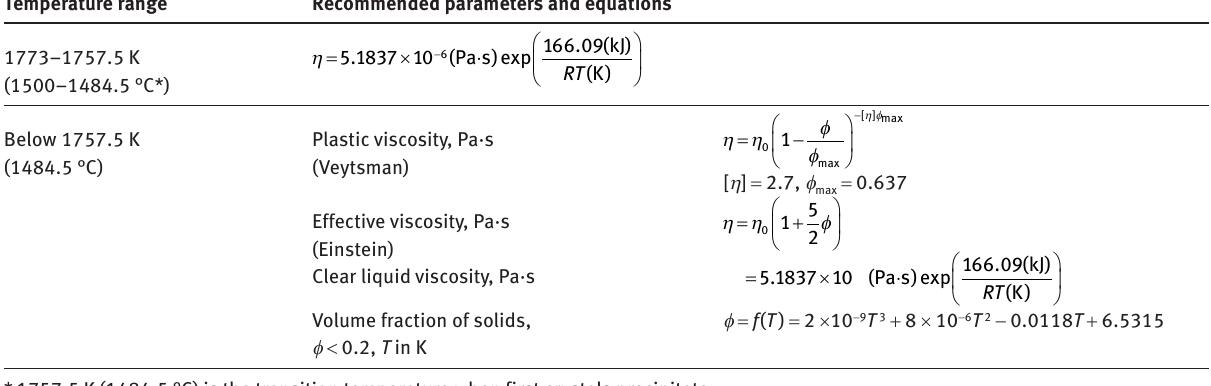
Table 6: Recommended parameters and equations for predicting plastic viscosity of US western coal slags (excluding ZrO 2 ) in the tempera- ture range of 1773–1573 K (1500–1300